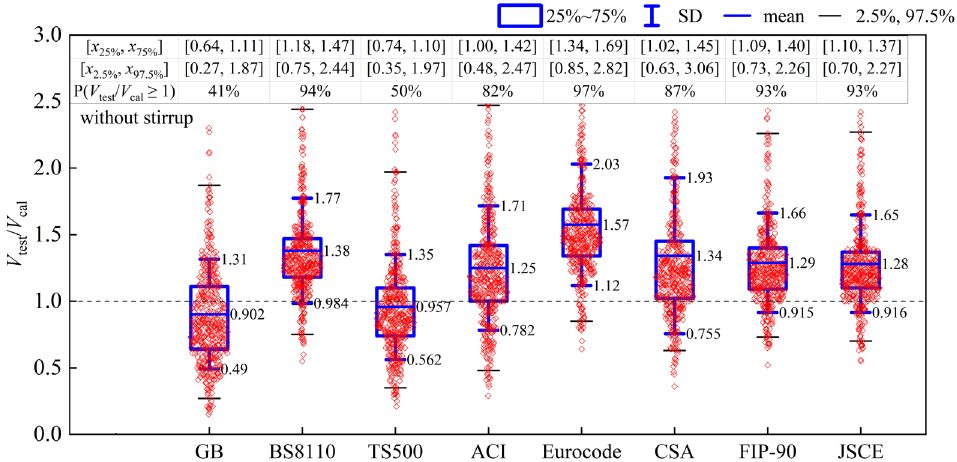
Figure 1. Codes: overall prediction results for beams without stirrup.